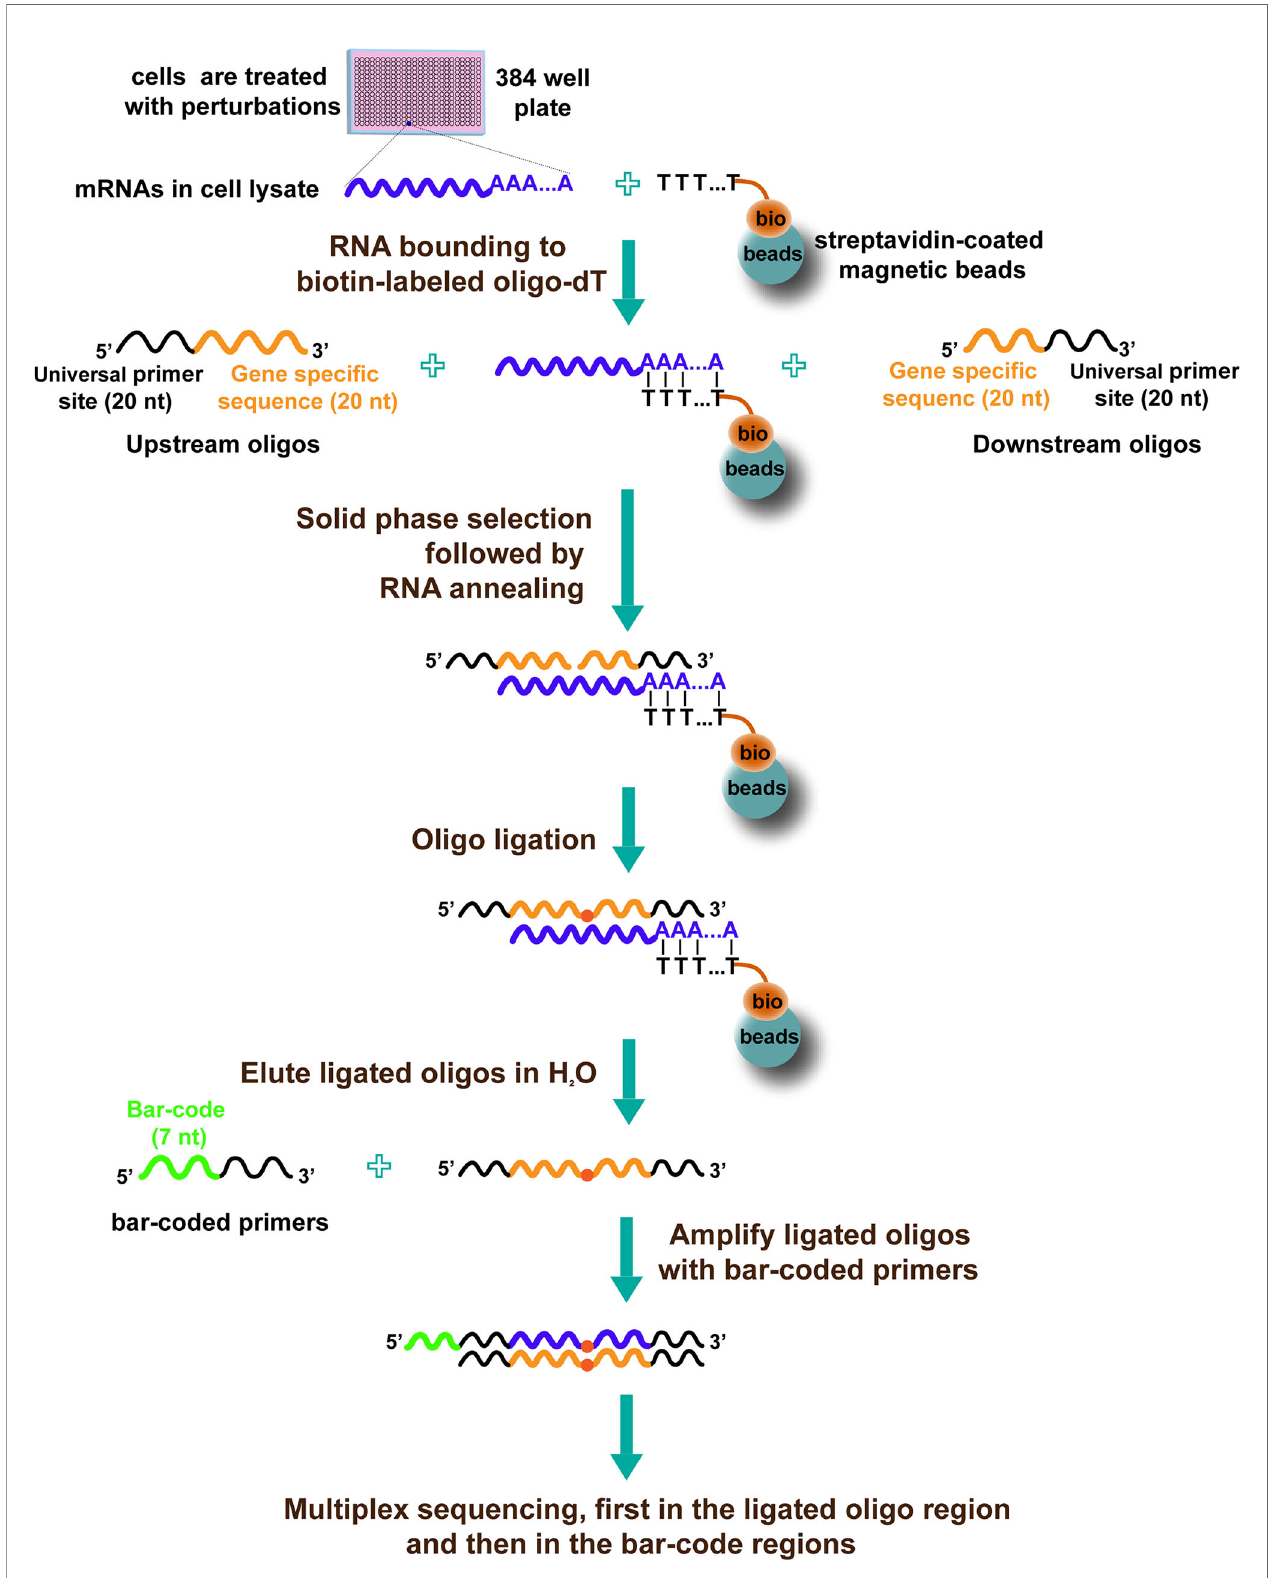
FIGURE 2 | The diagram of HTS 2